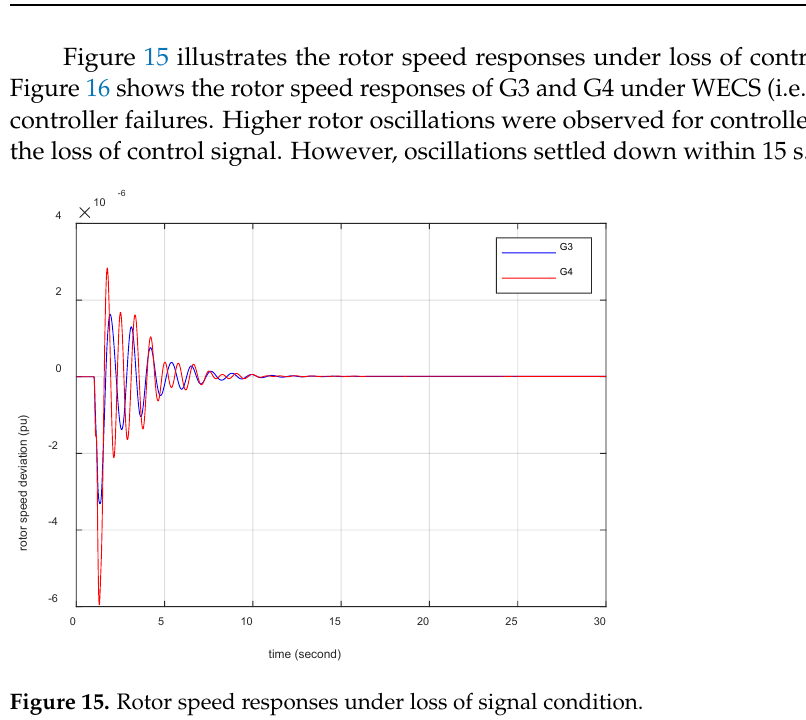
Figure 15. Rotor speed responses under loss of signal condition.